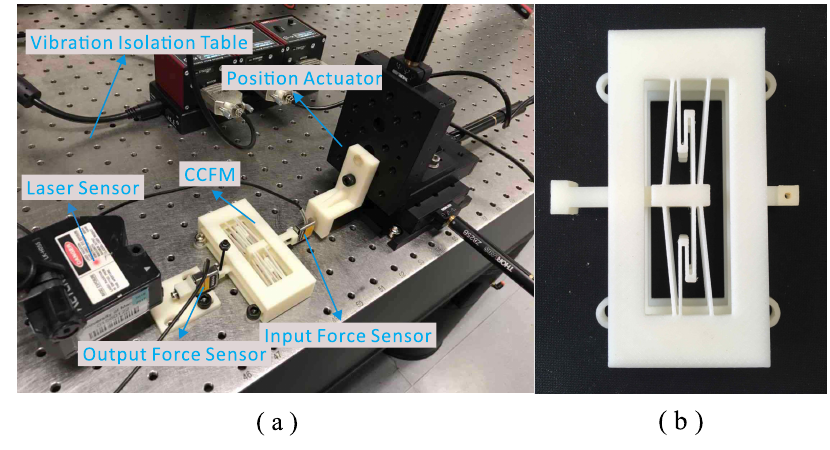
Figure 7. ( a ) Experimental setup; ( b ) Prototype of